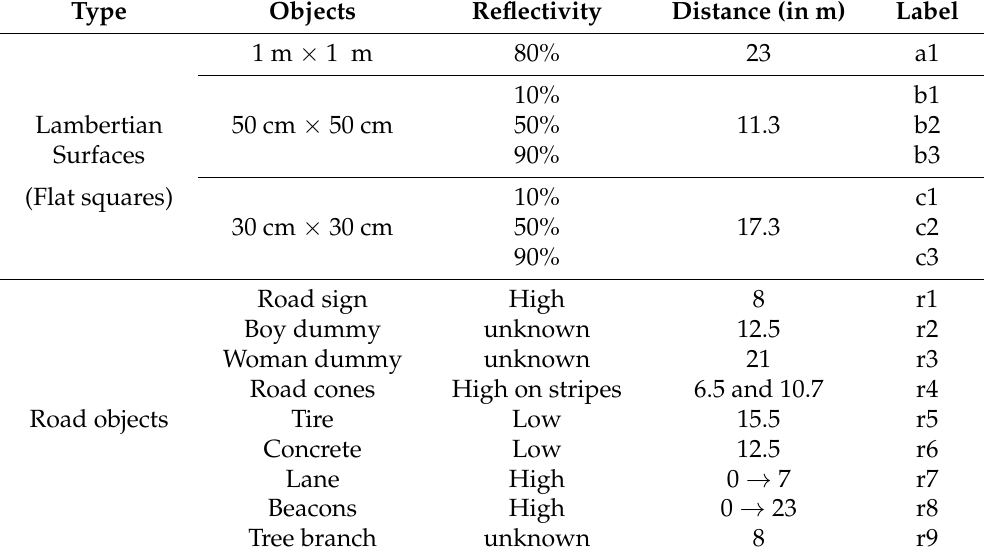
Table 2. List of targets used during the experiments.